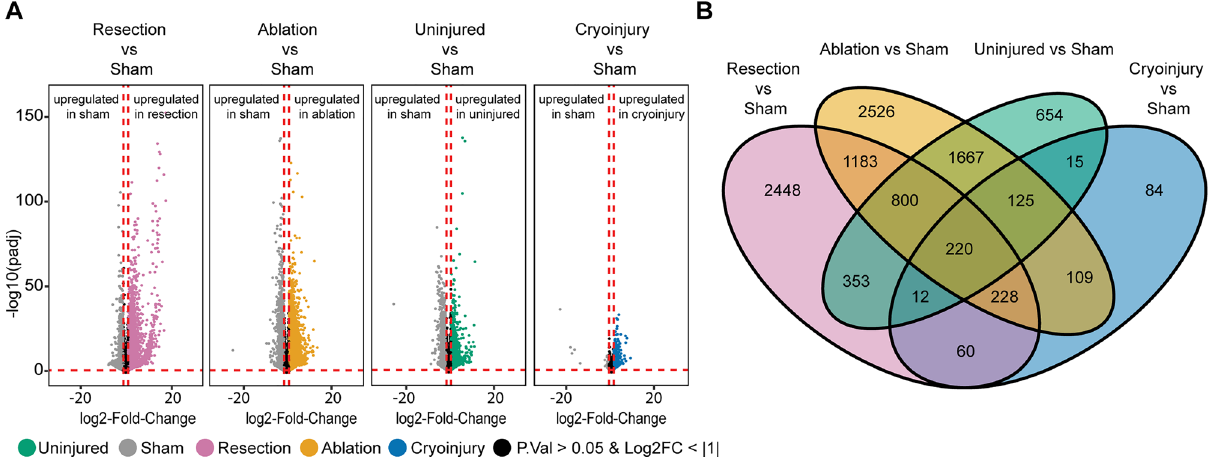
Figure 2. Unique and common differentially expressed genes (DEGs) in the 7 dpi regenerating zebrafish heart after resection, cryoinjury, or genetic ablation. ( A ) Volcano plot of the different conditions showing the DEGs. Grey, sham; orange, genetic ablation; magenta, ventricular resection; green, uninjured; blue, cryoinjury. Black area stands for non-significant genes with an adjusted p value > 0.05 or a log2FoldChange value > − 1 and < + 1 which were not considered for the analysis. ( B ) Venn diagram of the zebrafish DEGs converted to the respective mouse orthologs, for each